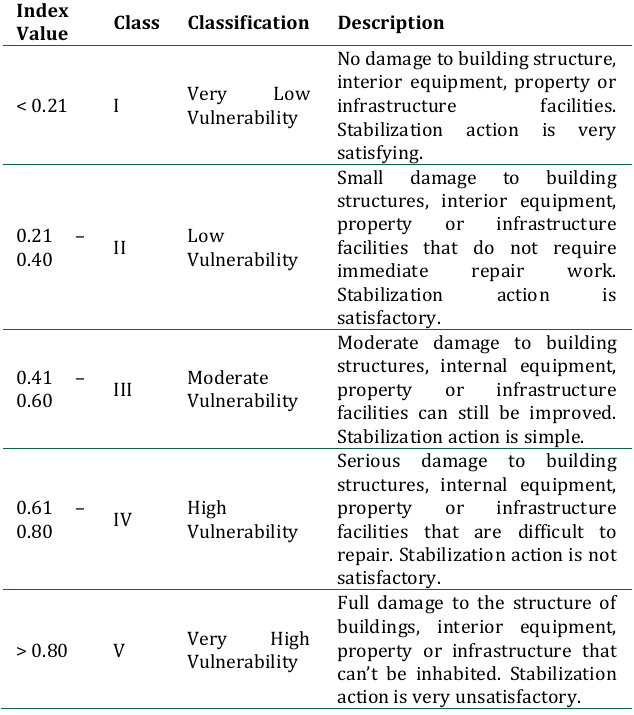
Table 2: Characteristics of Social Vulnerability (Vs) (Rodeano, 2015) Index